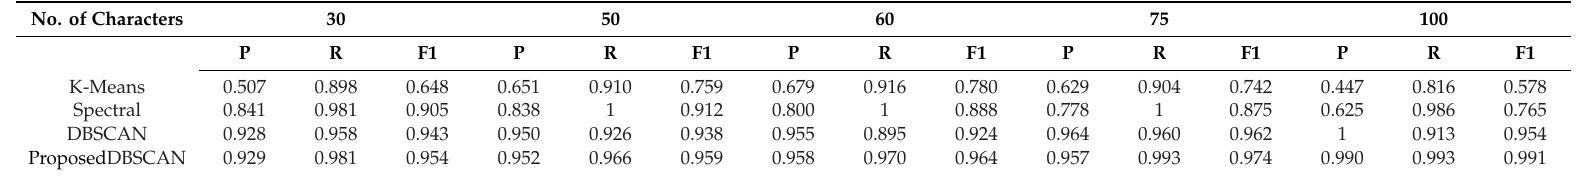
Table 3. Precision (P), Recall (R), F1-measure (F1) on Arabian faces dataset.